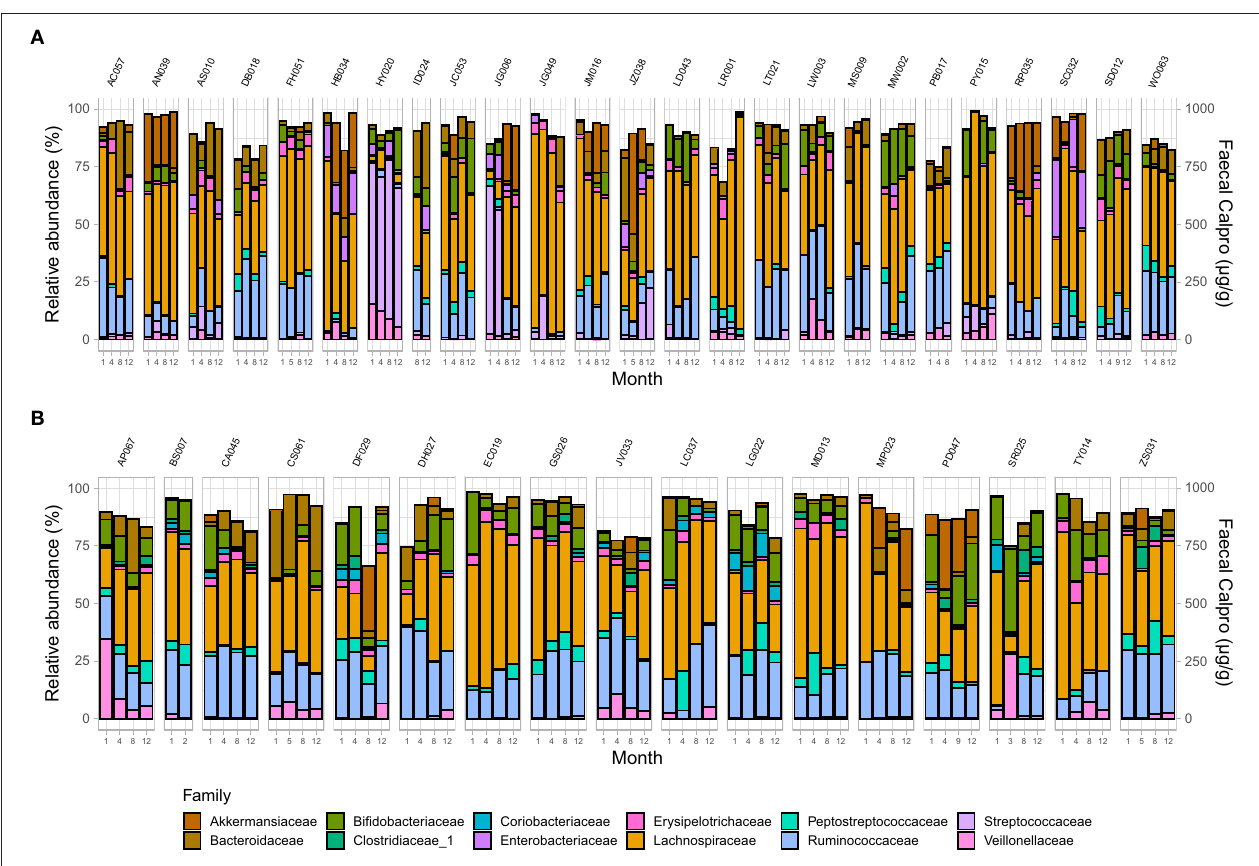
FIGURE 4 | Microbial community composition at family level in patients in remission. (A) CD, and (B) UC. Only families with a relative abundance ≥ 2% in any sample are shown.